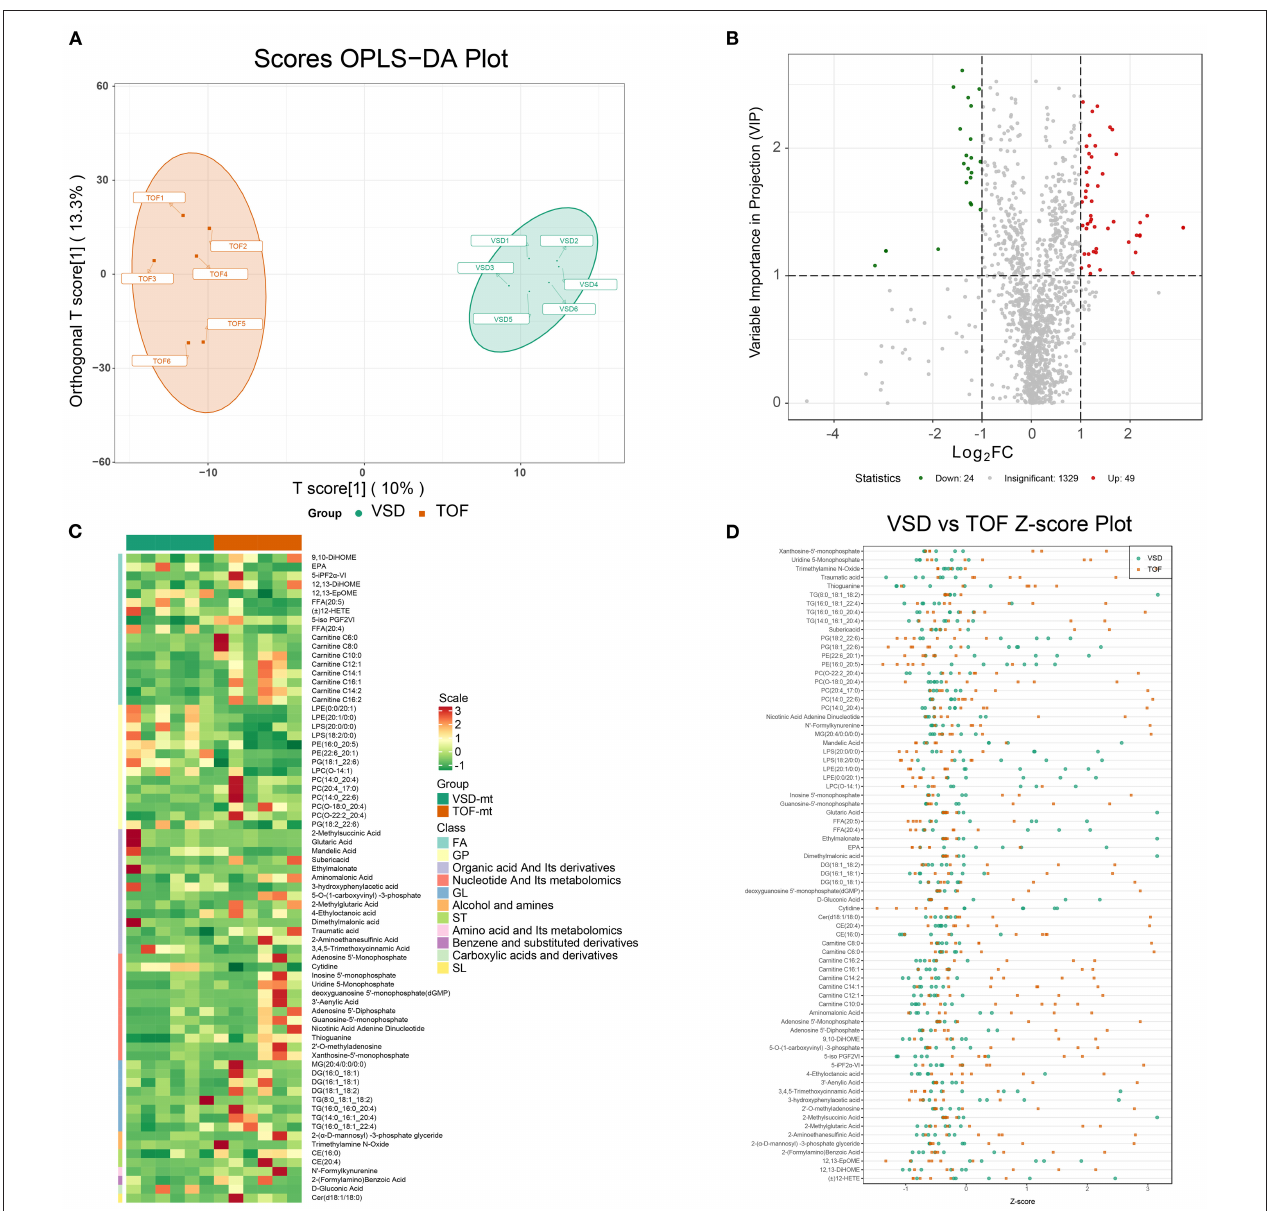
FIGURE 4 | Detection of differentially expressed metabolites in ToF and ASD RA specimens via the UPLC–MS/MS spectra. (A) T-score of OPLS-DA showing the distribution of ToF and ASD specimens. (B) Volcano plot showing the distribution of differentially expressed metabolites. (C) Differential expression of metabolites in ToF and ASD specimens. (D) Scatter diagram of Figure 3D showing the standardized Z-score for each sample. (cluster frequency = 3.92%, p = 9.93E − 03) ( Figures 5A,B